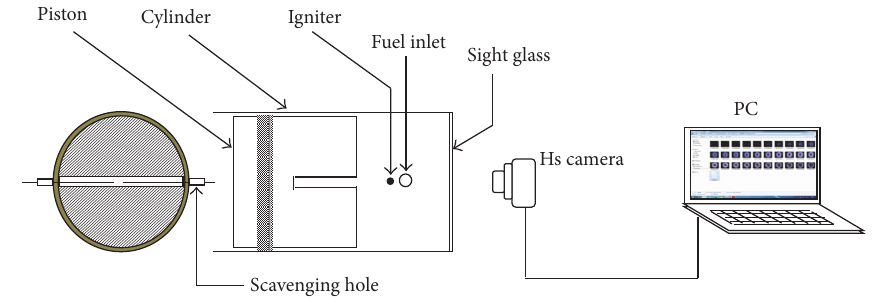
Figure 1: Experimental